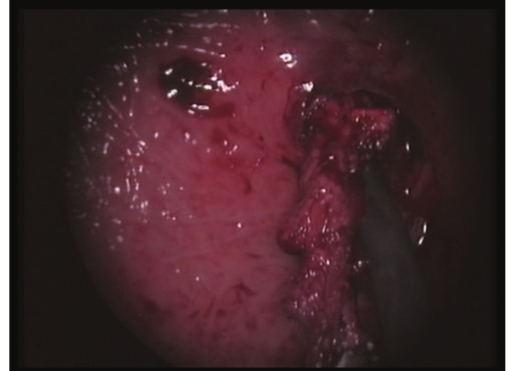
Figure 3: The ureter is completely dissected and freed from the bladder wall.